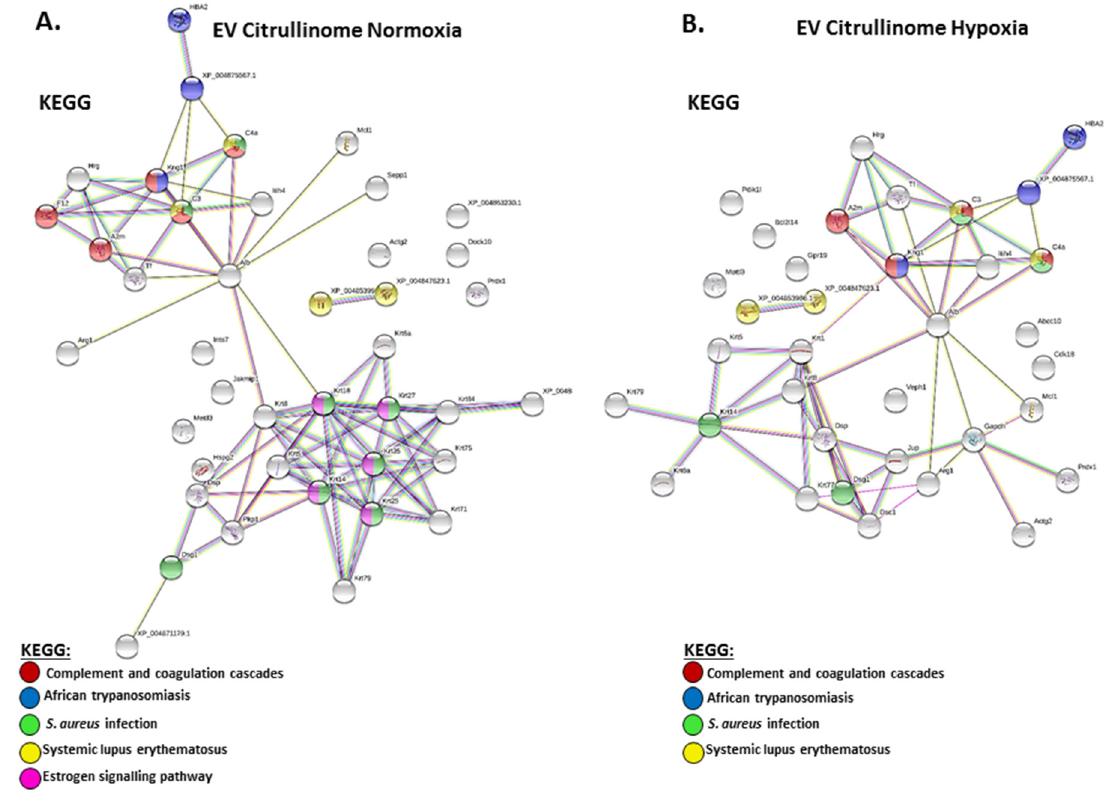
Figure 5. STRING analysis for the EV citrullinome, showing predicted protein networks and associated KEGG pathways for the plasma EV citrullinome from ( A ) normoxia-treated naked mole-rats and ( B ) hypoxia-treated naked mole-rats.